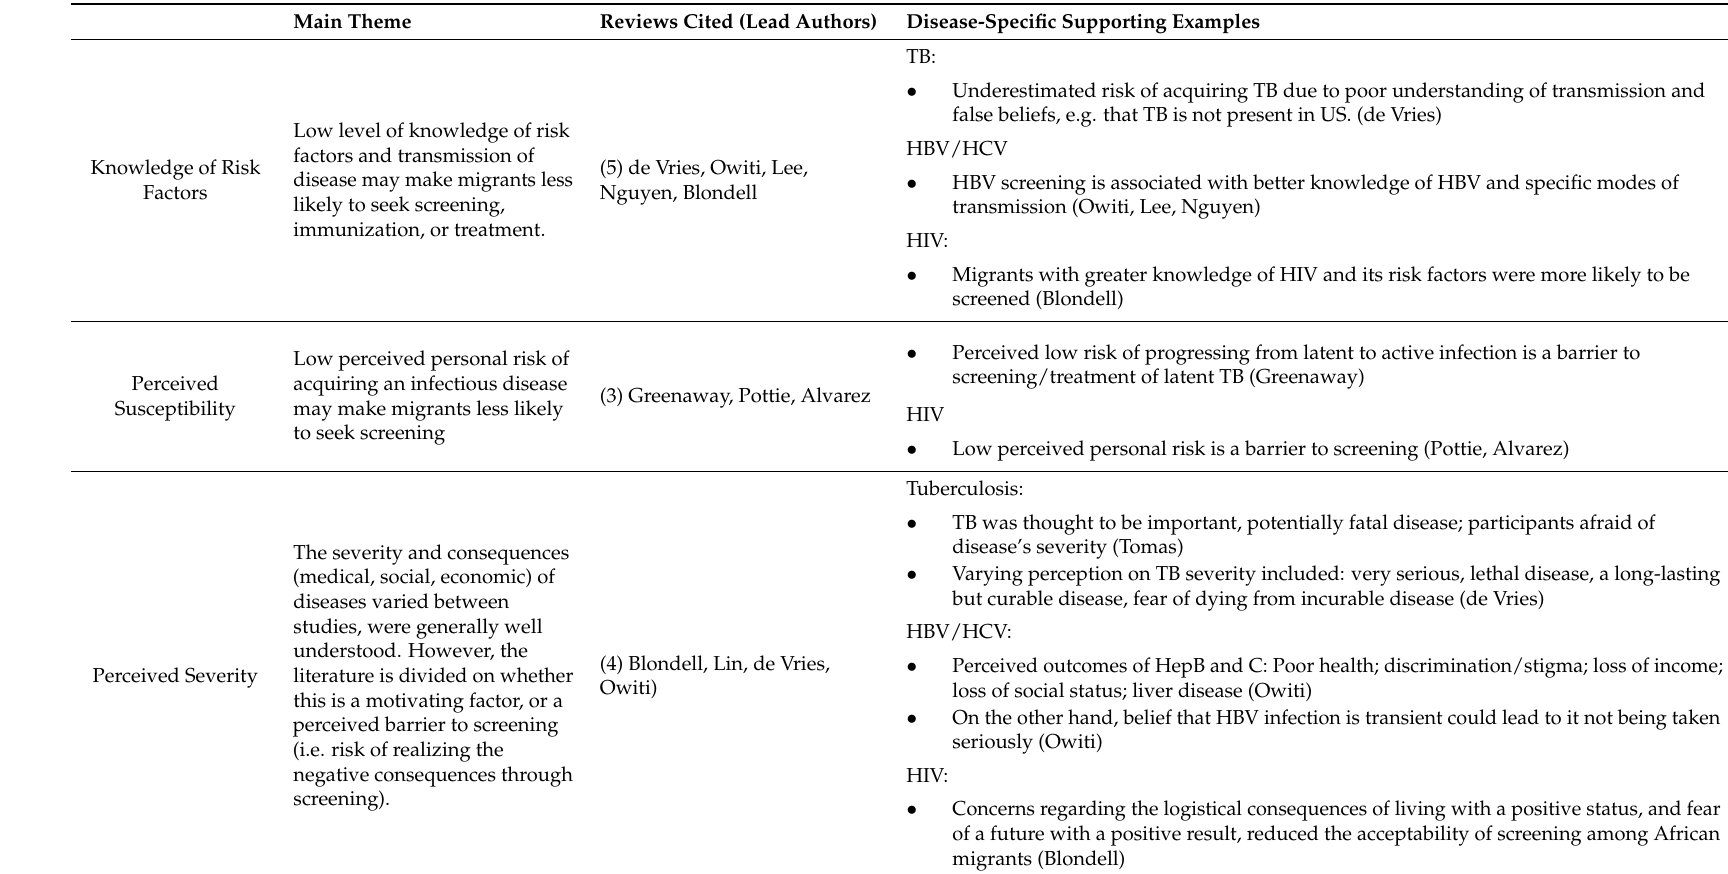
Table 2. Preliminary Findings from Health Belief Model Framework